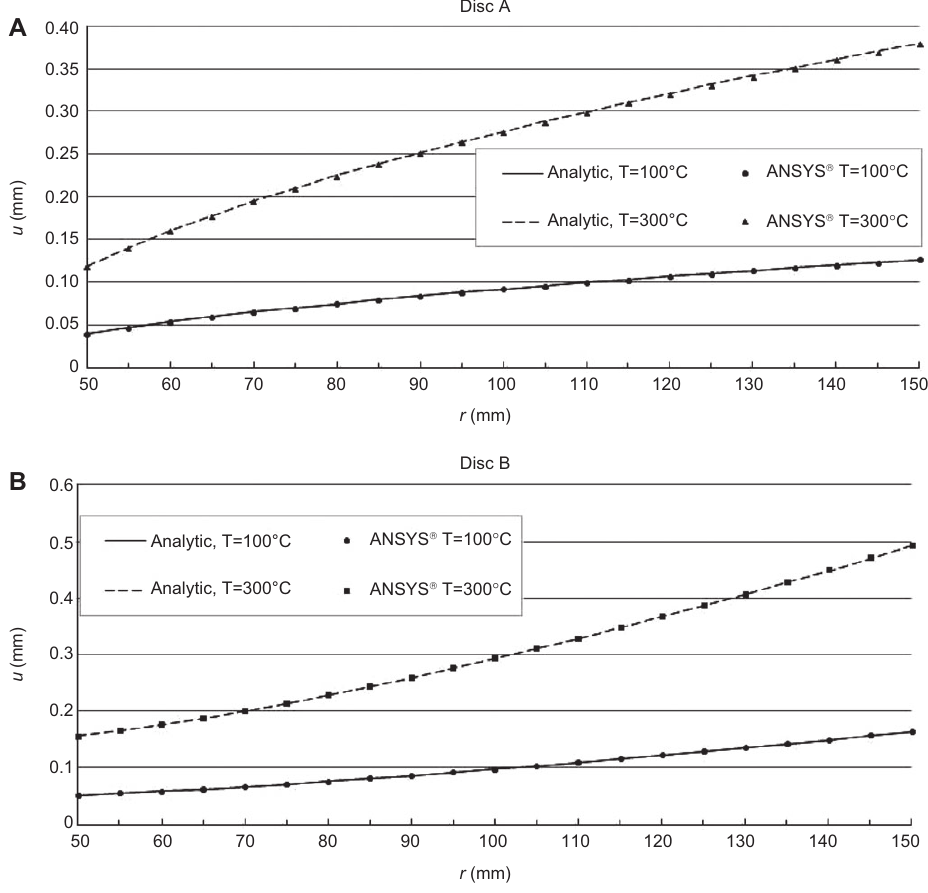
Figure 6 Variations of radial displacements at Disc A (A) and Disc B (B) under uniform